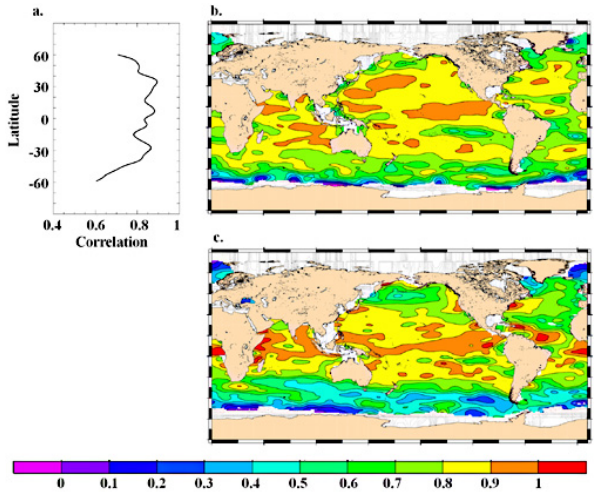
Fig. 1. Correlation coefficients (b) and regression coefficients (c) between SLA and DHA. The mean correlation as a function of lati- tude is also represented (a) .